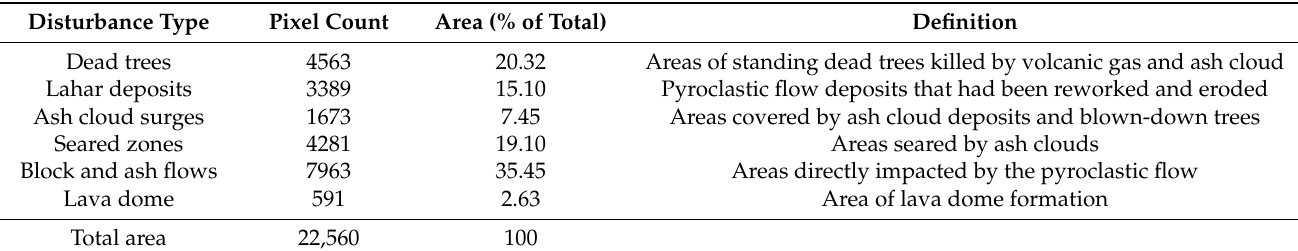
Table 2. Description and statistics of disturbance types defined by [47]. The pixel count and area values are based on our computation using boundaries shown in Figure